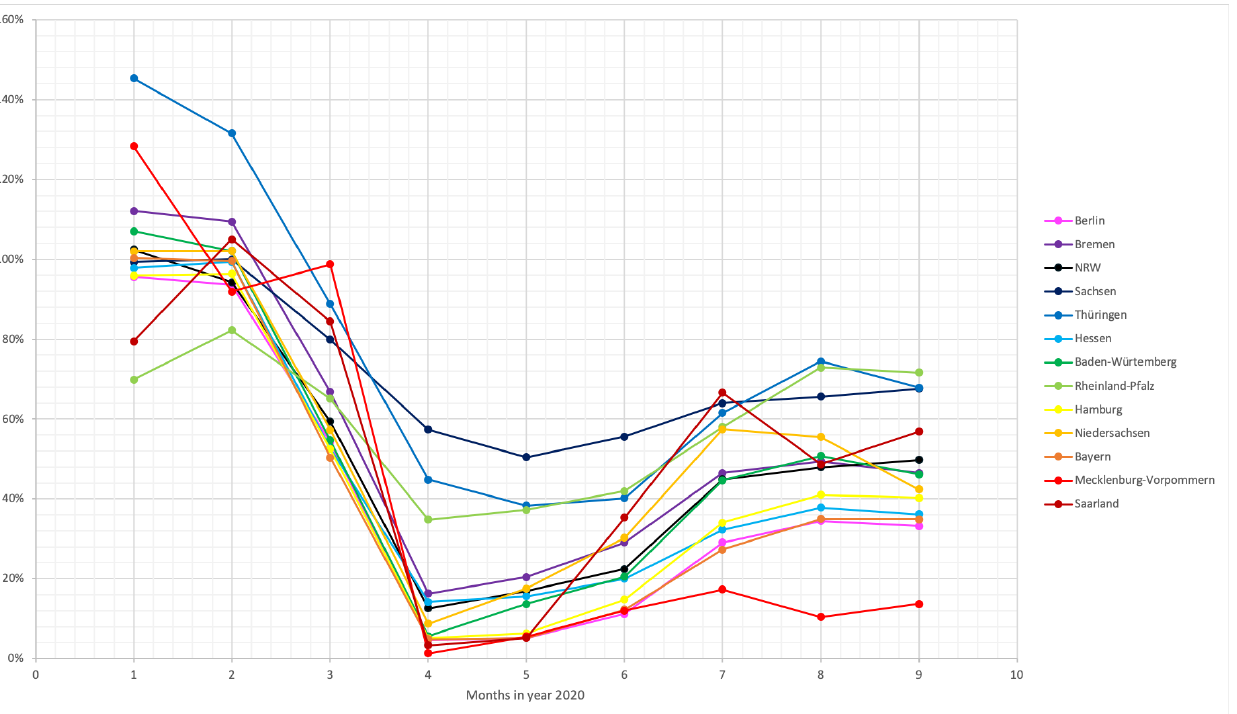
Figure 4. Flight data collected by the Federal Statistical Office of Germany in Reference [25]. A value of 100% is assigned if the number of outgoing and incoming flights in Germany for the respective region is the same as in the year